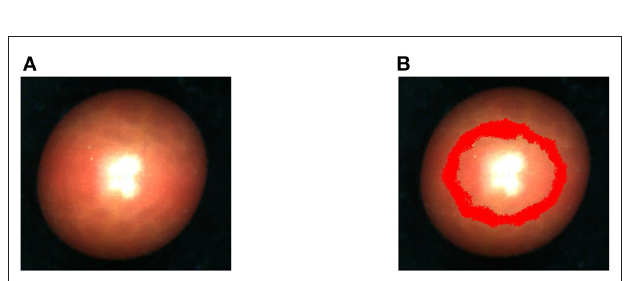
FIGURE 2 | (A) ENVI original hyperspectral image. (B) Area map of ROI acquired by ENVI.